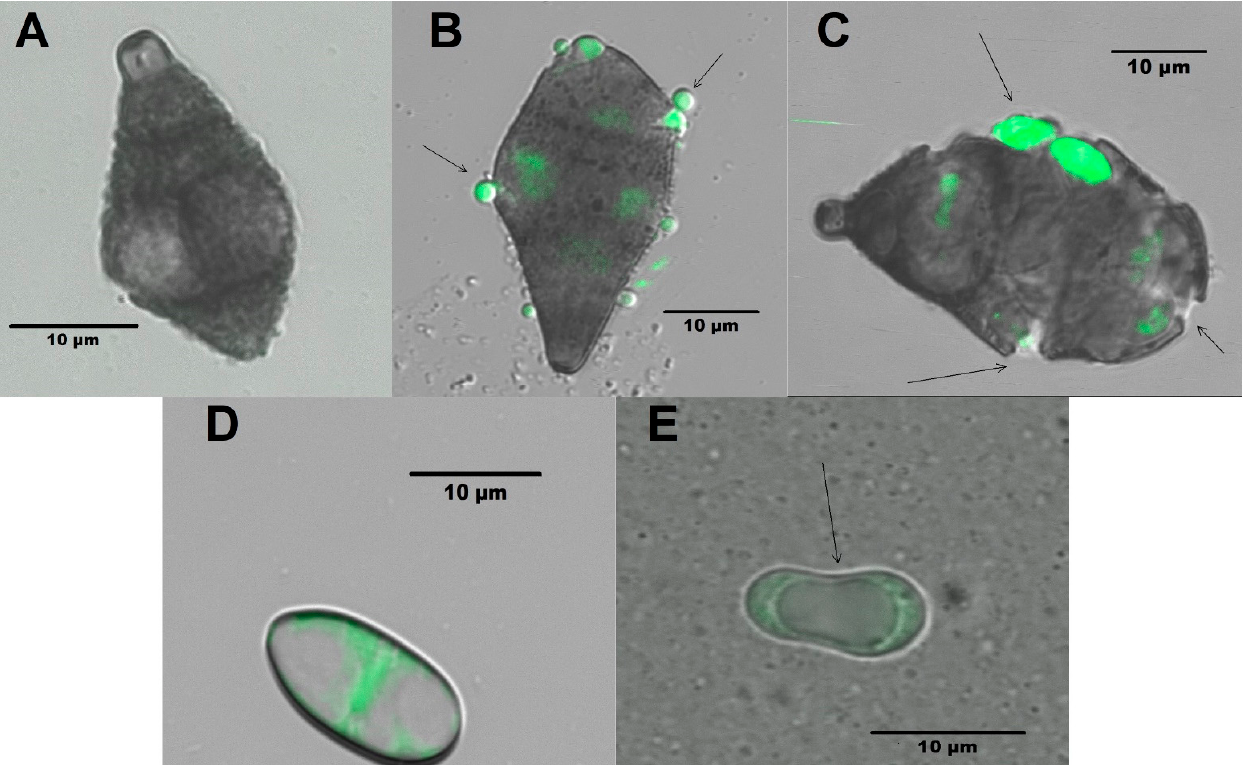
Figure 5. Conidia of A. alternata without treatment ( A ) and treated ( B , C ) with a mixture of cell-free extracts of P. fluorescens and chitosan [50–1.5% ( v / v )]. Conidia of F. solani without treatment ( D ) and treated ( E ) with a mixture of cell-free extracts of P. fluorescens and chitosan [50–1.5% ( v / v )].